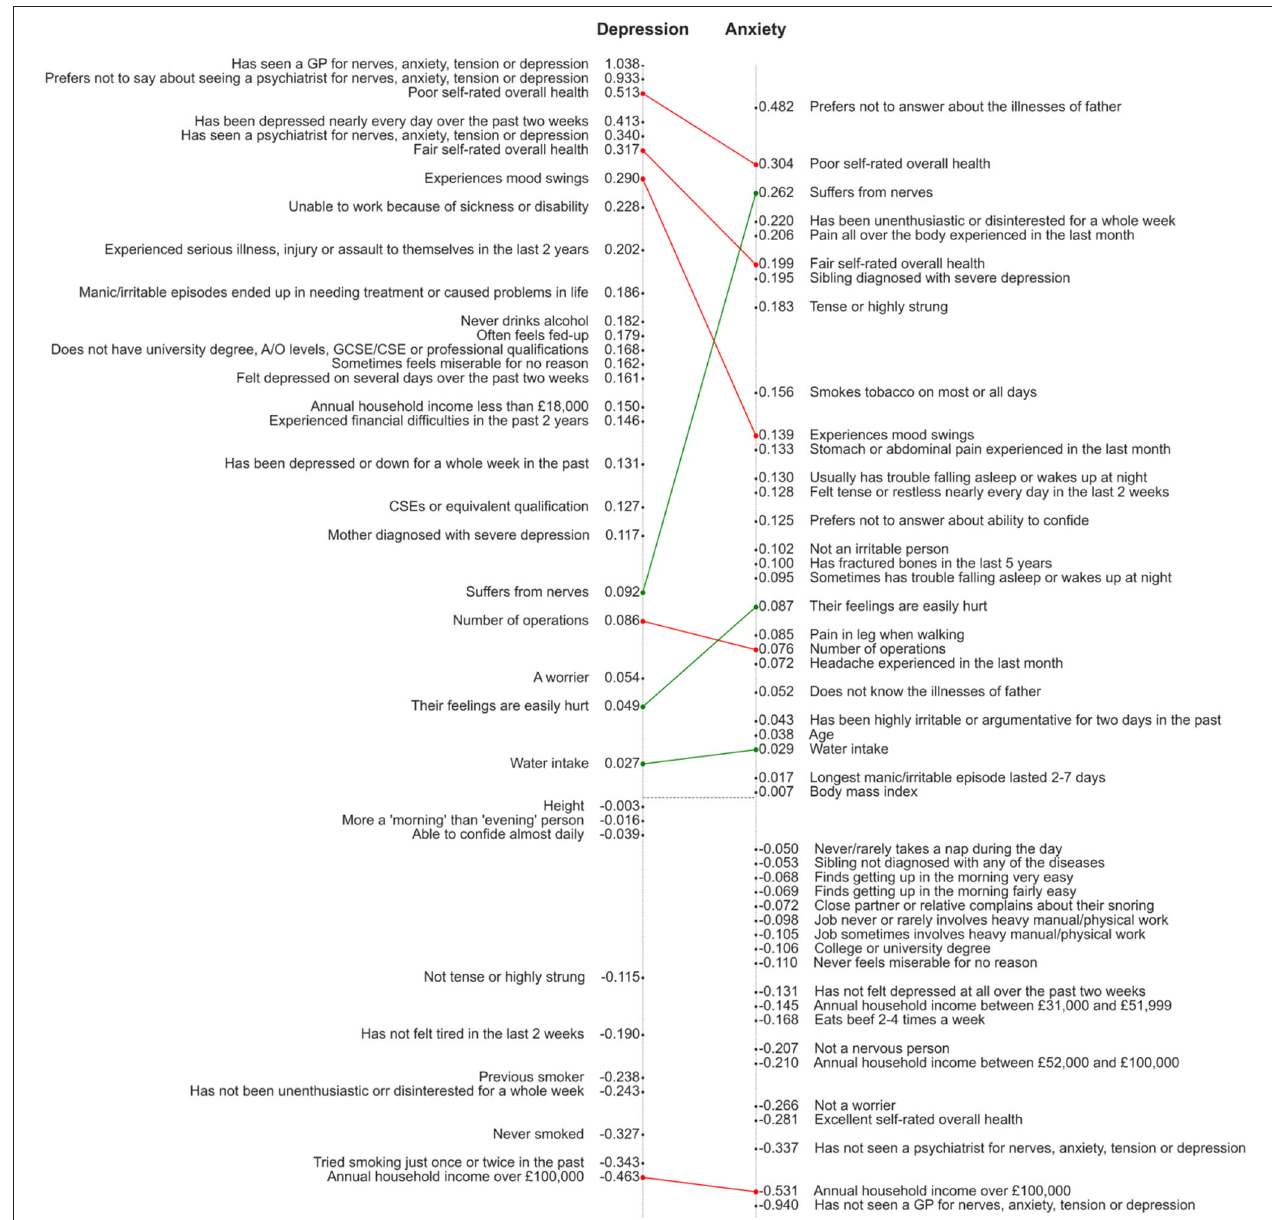
FIGURE 2 | Visual comparison of the reduced models for depression and anxiety. Features are positioned on the y axes in the order of descending coefficients but the distance between points is not proportional to the difference between coefficients. Connecting lines are shown in red (for common factors with a higher coefficient in the depression model) or green (higher coefficient in anxiety